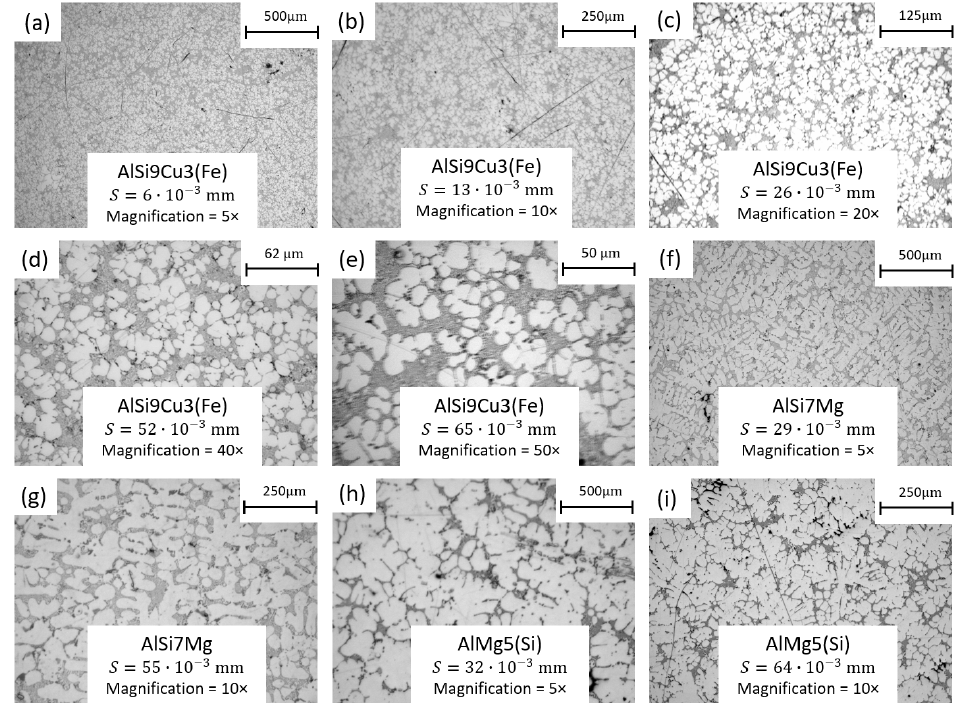
Figure 7. Images of materials used during the training: The images were split into 200 × 200 pixel images following the procedure in Figure 5 and used for the prediction task.